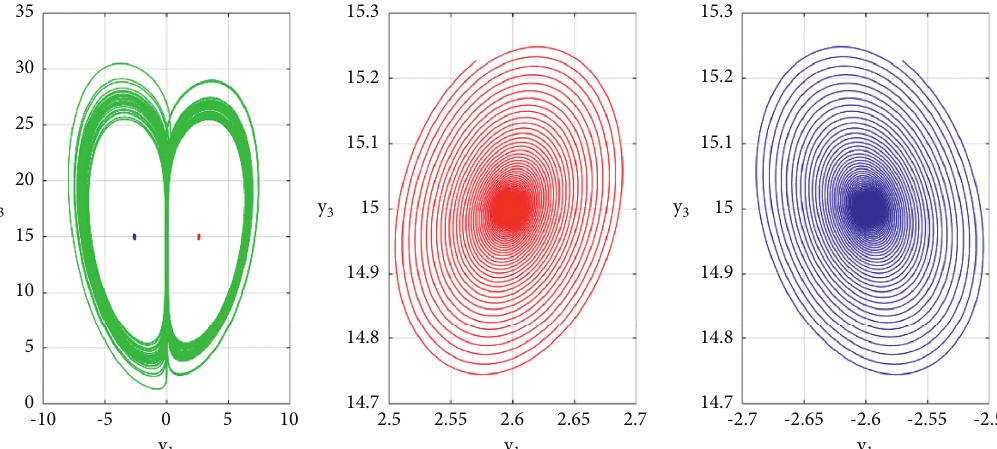
y − plane with parameter selection A 1 3